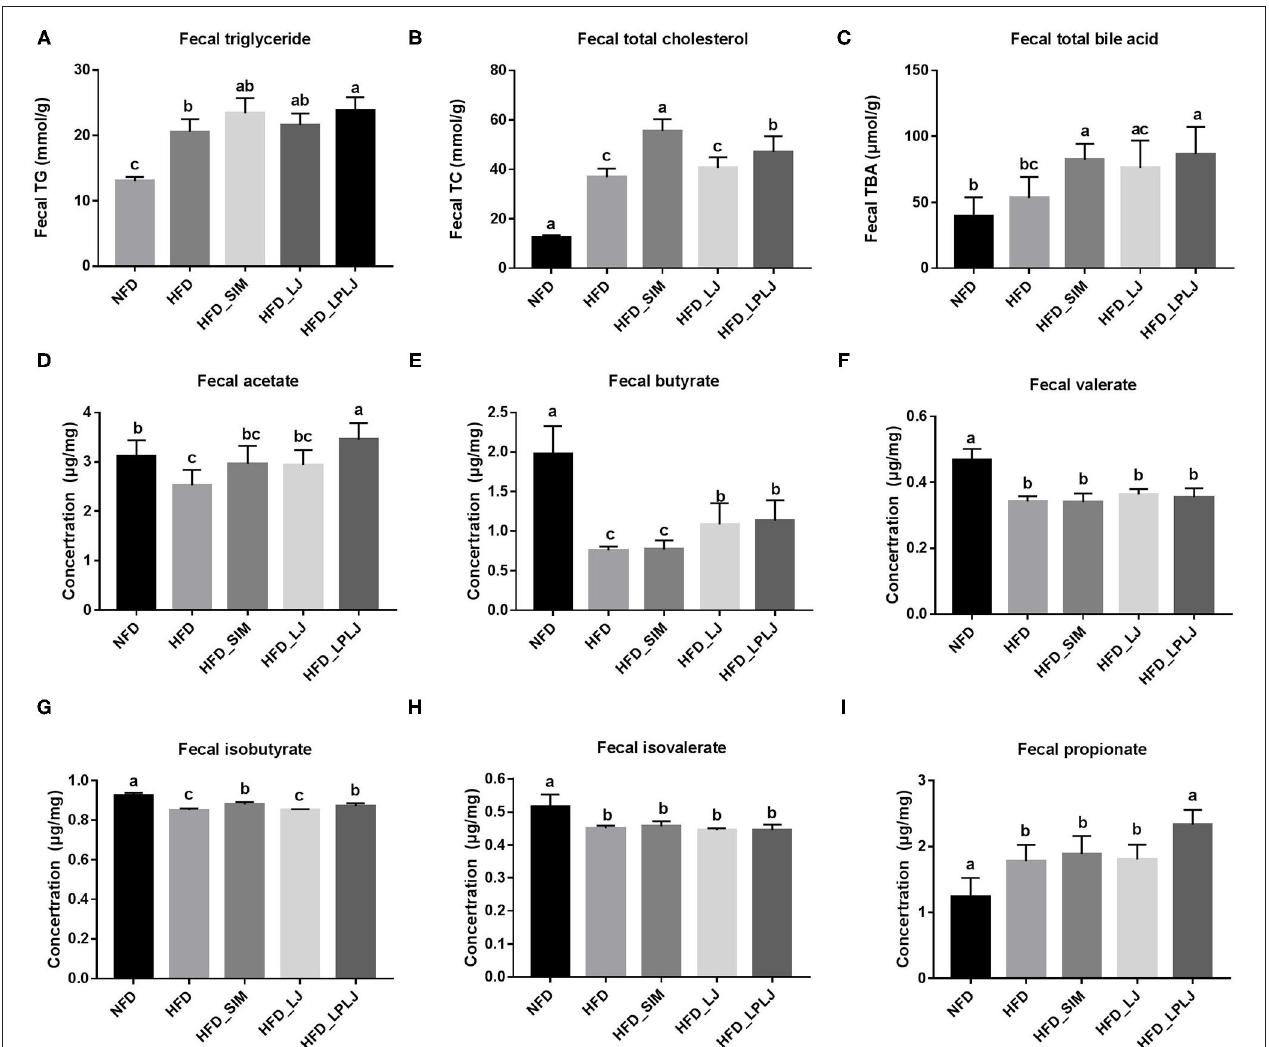
FIGURE 4 | Effect of LPLJ consumption on the fecal lipid levels and short-chain fatty acids (SCFAs) in rats fed a high fat diet. (A) TG, (B) TC, (C) TBA, (D) fecal acetate, (E) fecal butyrate, (F) fecal valerate, (G) fecal isobutyrate, (H) fecal isovalerate, and (I) fecal propionate levels. a-c, Mean values with different letters in the same column differ significantly ( p <